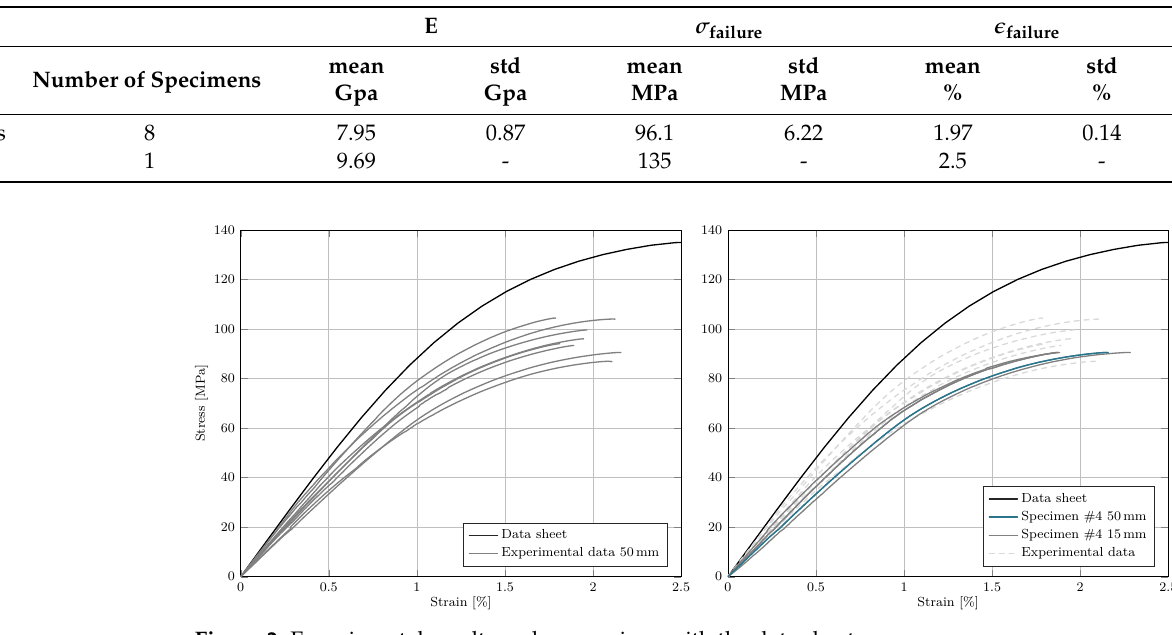
Figure 2. Experimental results and comparison with the data